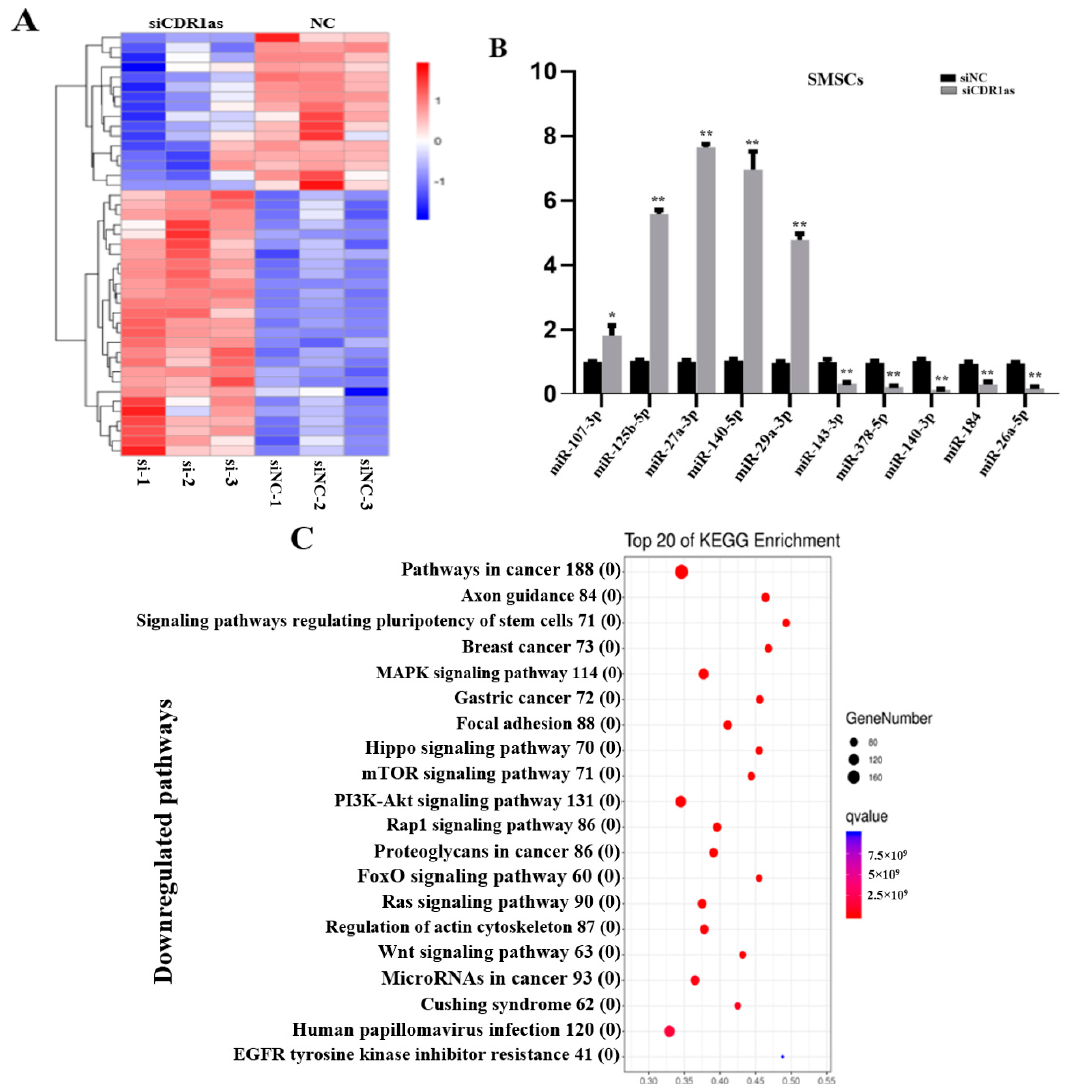
Figure 1. Differentially expressed miRNAs in siCDR1as and siNC (SMSCs). ( A ) Sequencing analysis for miRNAs was performed from siCDR1as ( n = 3) and siNC ( n = 3) of SMSCs. Hierarchical cluster analysis of DE miRNAs: bright red, overexpression; white, no change; bright blue, under-expression. ( B ) Differential expression of 10 representative miRNAs was validated in siCDR1as and siNC of SMSCs by qRT-PCR ( n = 10 per group). The number of ‘’*” indicates the level of significance (**, p < 0.01, *, p < 0.05). ( C ) KEGG analysis of the upregulated miRNA-mRNA network. The rich factor indicates the ratio of the number of DEGs mapped to a certain pathway to the total number of genes mapped to this